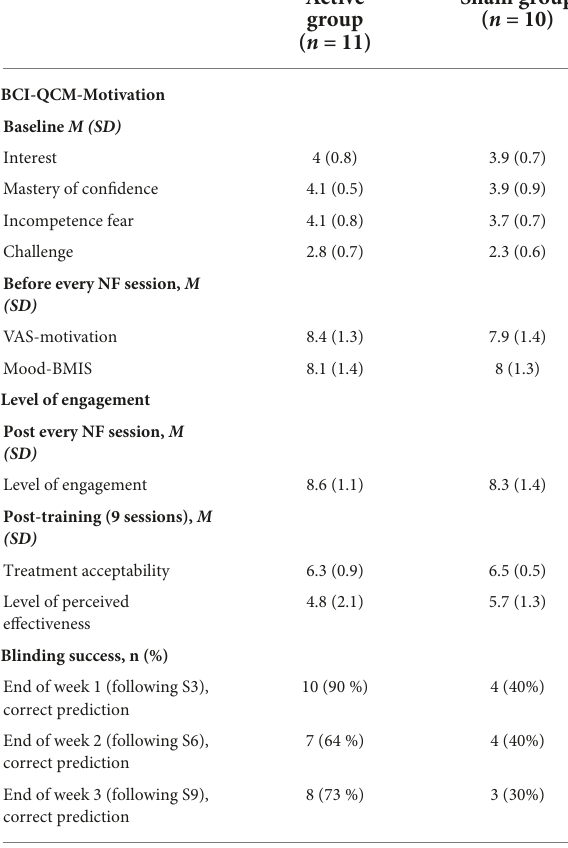
TABLE 3 Motivation and engagement levels and success of participant